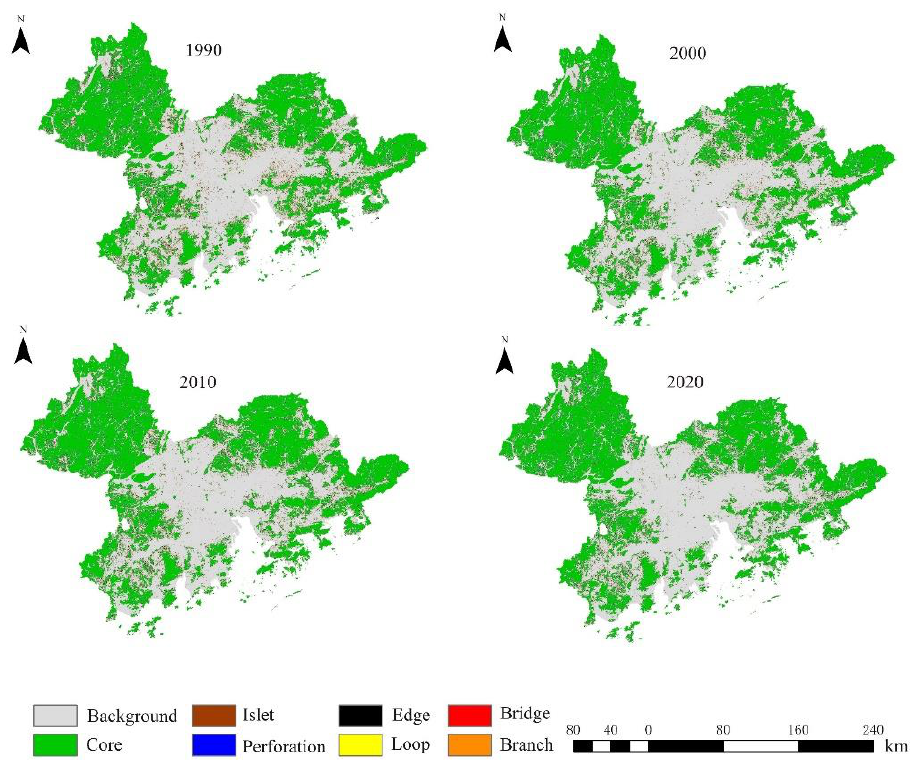
Figure 4. Landscape type map of the study area based on MSPA.